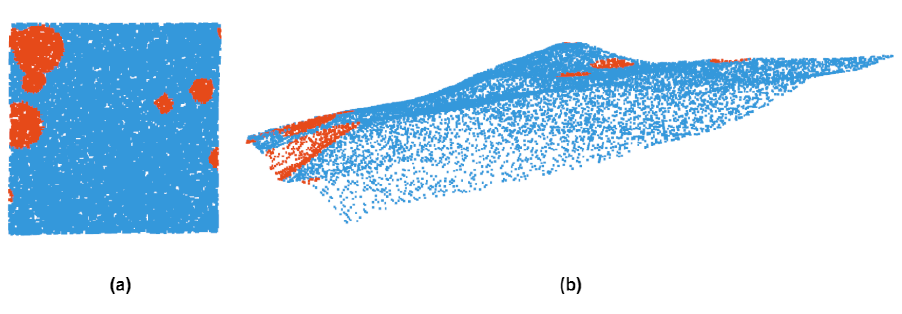
Figure 3. Point cloud dataset. ( a ) shows a vertical view of an area in the point cloud dataset, and red marks the impact craters. ( b ) represents the point cloud data of the region from another